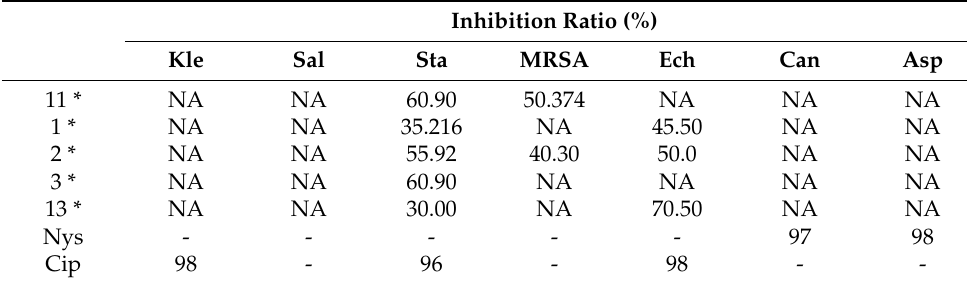
Table 4. In vitro antimicrobial activity of DCM Fraction purified